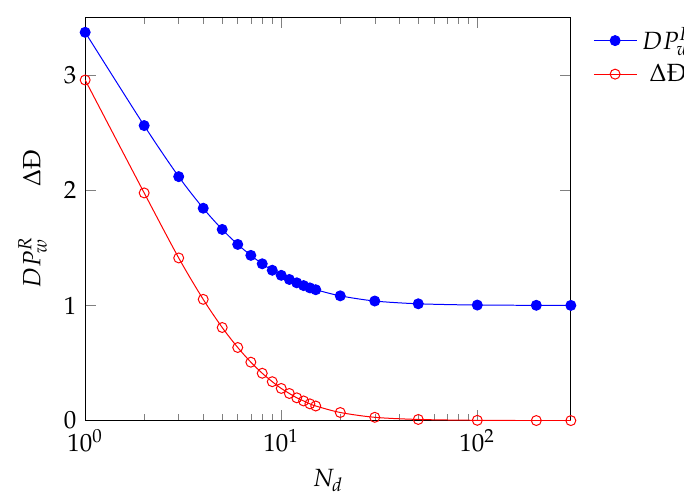
Figure 10. Quality measures for the reproducibility of the product of tests SBR7 in a continuous series of PFRs according to the number of reactors in the series.